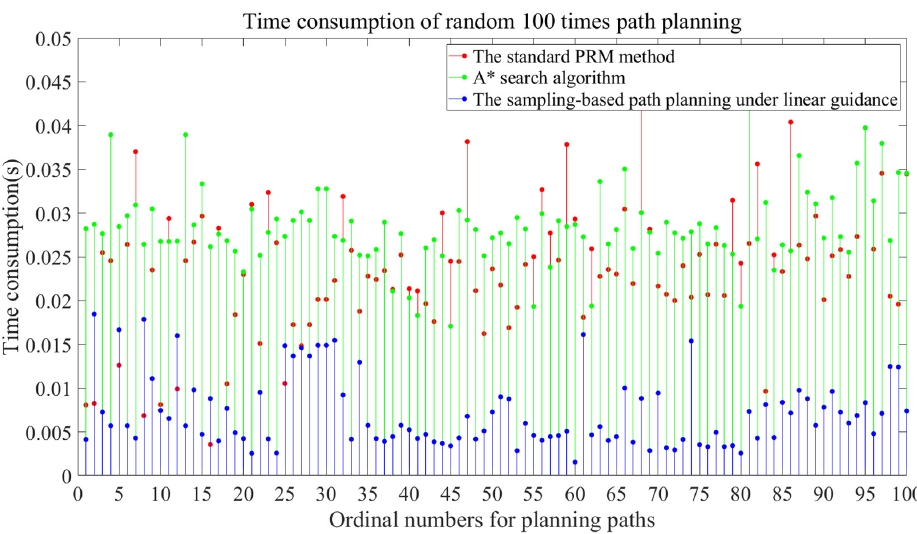
Figure 24. Comparison of time consumption in path planning.